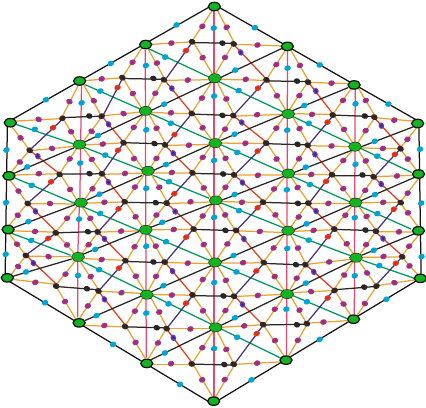
Figure 3: A 4-dimensional subdivided hex-derived network of a second Γ 1 ð 4 Þ